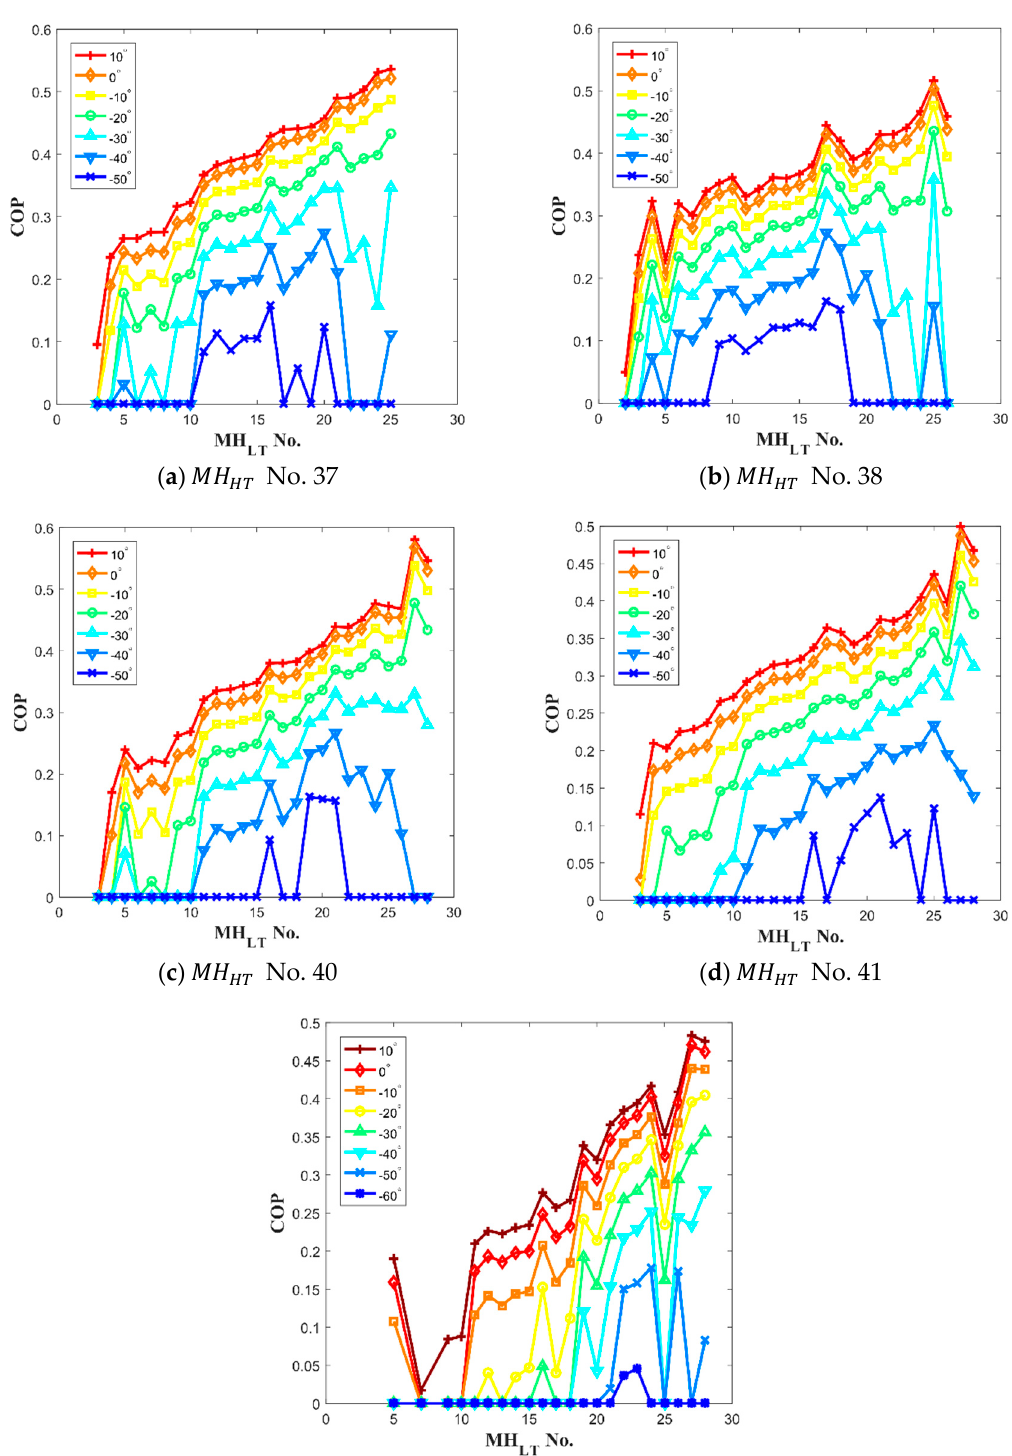
Figure 6. The calculation result of COP cool with each MH LT hydride paired to MH HT of ( a ) No. 37; ( b ) No. 38; ( c ) No. 40; ( d ) No. 41; and ( e ) No. 42. The results provide a base to select the best hydride pairs to the various objective cooling temperatures.